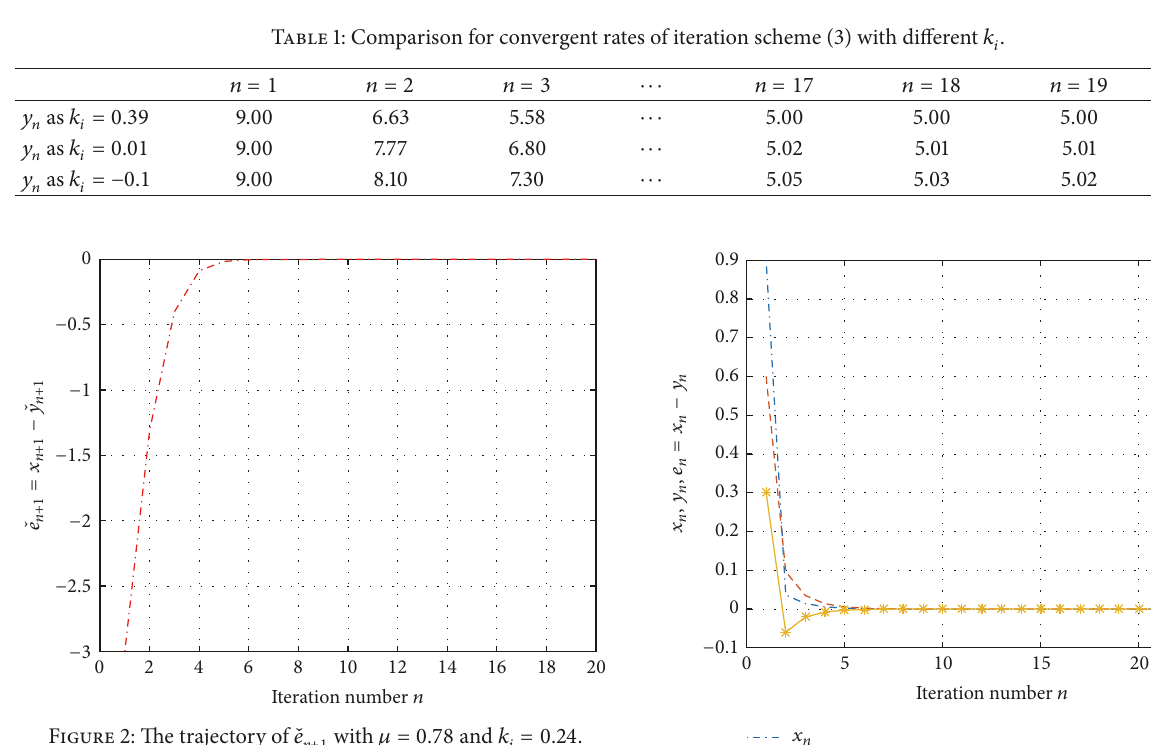
lim 𝑛→∞ ‖𝑥 𝑛+1 − ̃𝑦 𝑛+1 ‖ = 0 , which indicates the effectiveness of Theorem 7.